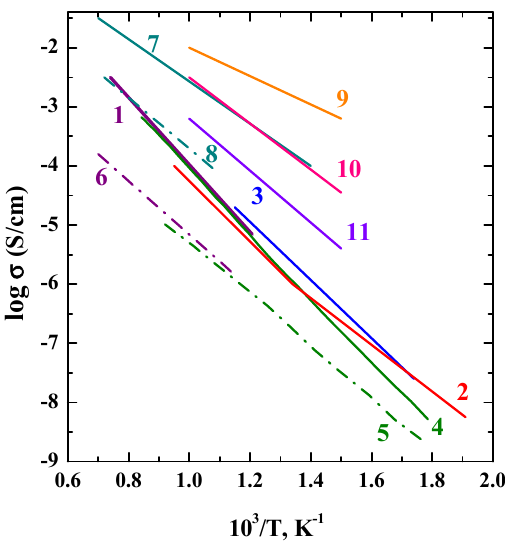
Figure 10. The temperature dependencies of total (solid line) and oxygen-ionic (dash dot line) conductivities of the compositions BaNdInO 4 (1 and 6) [68], BaNdInO 4 (2) [82], BaNdInO 4 (3) [72], BaLaInO 4 (4 and 5) [76], BaNd 0.9 Sr 0.1 InO 3.95 (7 and 8) [68], BaNdIn 0.9 Cr 0.1 O 4 (9) [71], BaNdIn 0.9 Mg 0.1 O 4 (10) [71], BaNdIn 0.9 Ti 0.1 O 4 (11) [71].